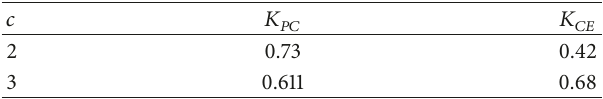
Table 1: Evaluation indicators of clustering